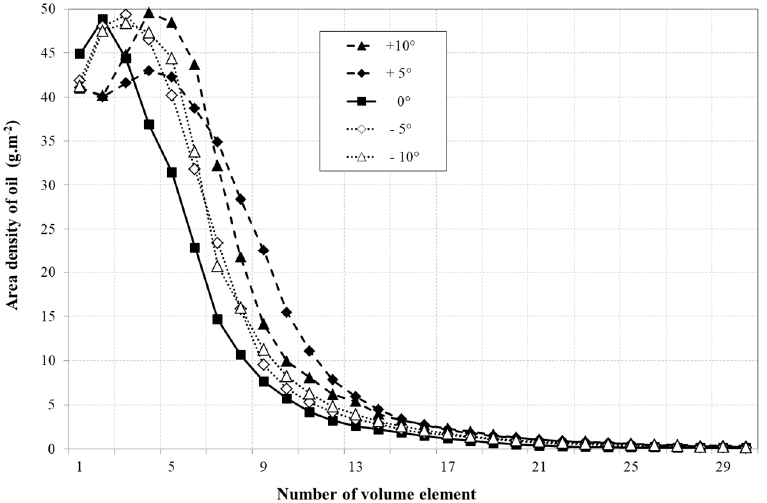
Figure 12. The course of the surface density of the oil film depending on the vertical change in the direction of the input velocity vector.